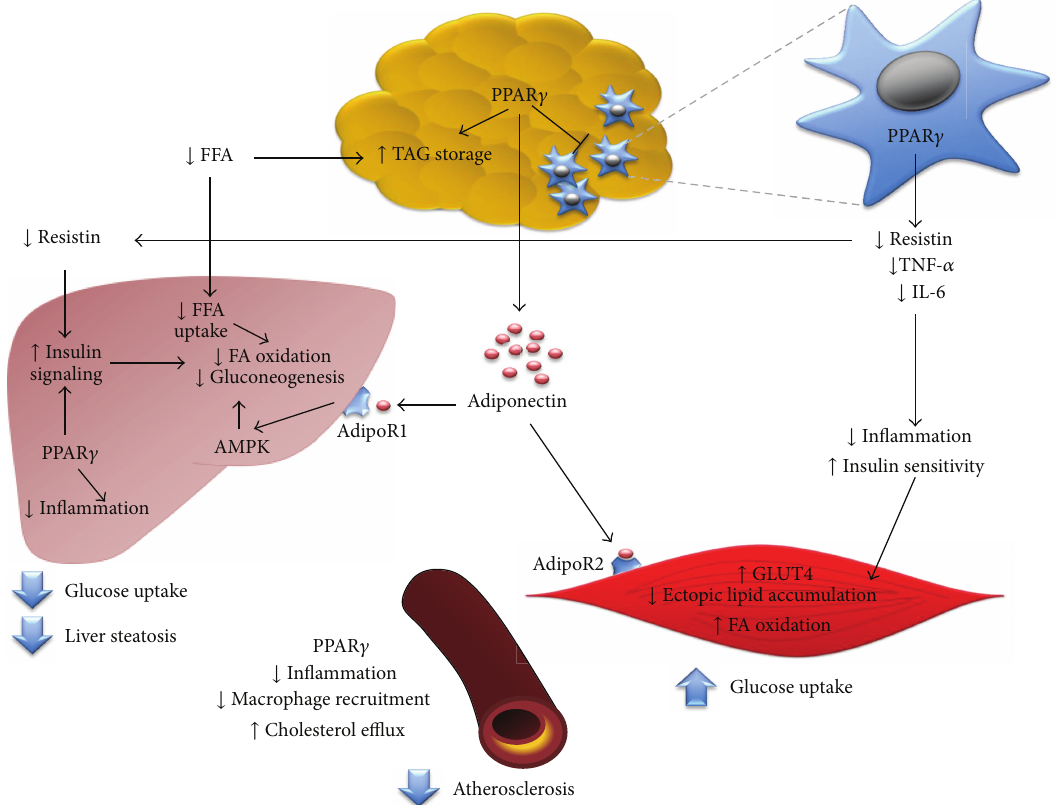
Figure2: Physiological and metabolic roles ofPPAR 𝛾 . InadiposetissuePPAR 𝛾 isinvolved in lipidstorage, which reduces circulating freefatty acids (FFA). In adipose tissue PPAR 𝛾 blocks the proinflammatory role of macrophages as well the secretion of resistin both by macrophages and adipocytes which favors the uptake and metabolism of glucose in the liver, muscle, and other peripherals organs. Adipose tissue also secretes adiponectin, which favors indirectly the activation of AMP kinase in the liver, heart, and muscle. AMPK phosphorylates a number of enzymes involved in fatty acid oxidation and glucose metabolism as well the synthesis and release of GLUT4. In the endothelial tissue, PPAR 𝛾 favors the cholesterol efflux and at the same time, as consequence of the lowering of inflammatory signals, the recruitment of macrophages, thus delaying the atherosclerosis. Overall, the outcome of downstream effectors results in the decrease of proinflammatory cytokines, free fatty acids, and plasma glucose by increasing its uptake resulting in the increase of generalized insulin sensitivity and reduction of lipid accumulation in the liver, cardiac and skeletal muscle, and arteries as well as the diminishing of chronic inflammation, prothrombotic state, and